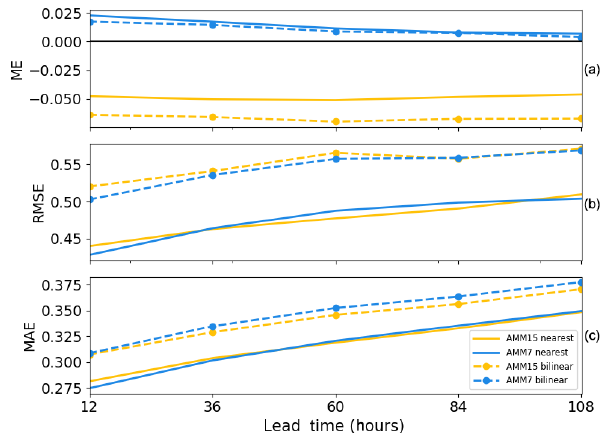
Figure 7. Verification results using a typical statistics approach for January–September 2019. Mean error (a) , root mean square er- ror (b) and mean absolute error (c) results are shown for the two model configurations. Two methods of matching forecast to obser- vations points have been used: a nearest-neighbour approach (solid) representing the single-grid-point results from HiRA and a bilinear interpolation approach (dashed) more typically used in operational ocean